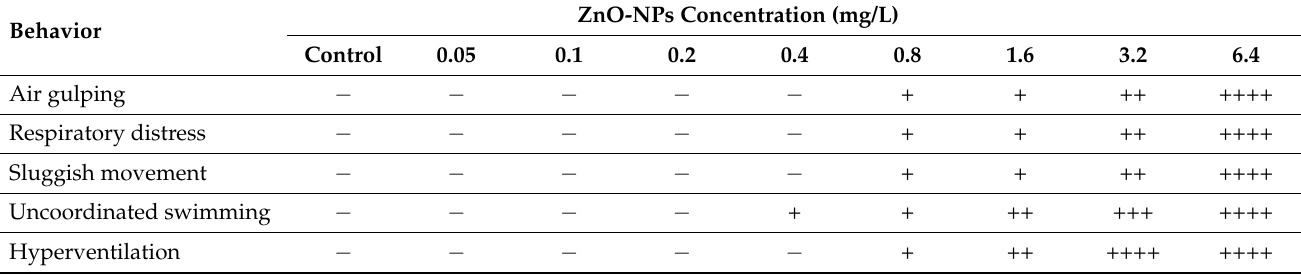
Table 2. Behavioral changes in the adult zebrafish males exposed to different concentrations of ZnO-NPs for 96